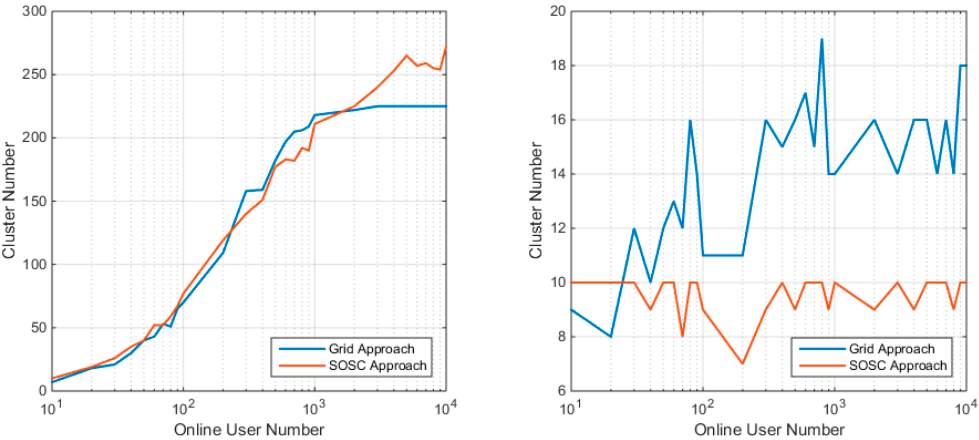
Figure 10. Cluster number of clustering with the grid approach and SOSC approach under uniform distribution ( left ) and clustered distribution ( right ).